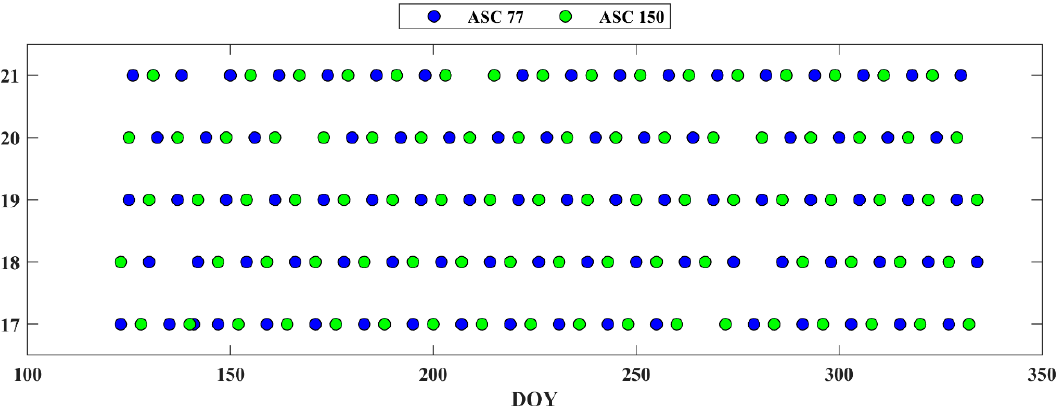
Figure 3. Sentinel-1 data acquisition date. The x -axis is the day of the year (DOY) and the y -axis indicates the years. ASC represents the ascending